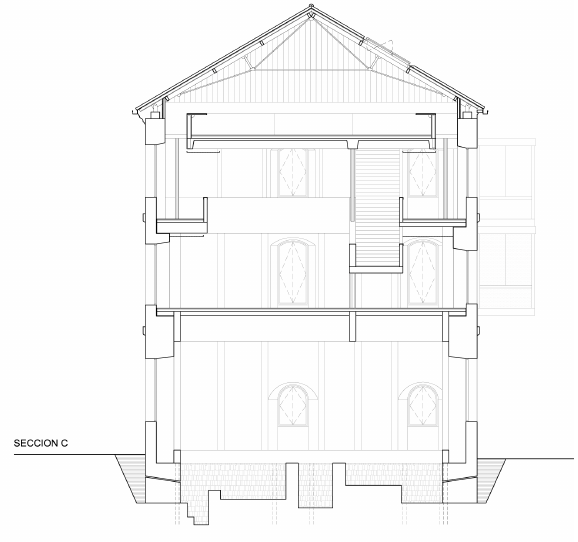
Figure 12. Cross-section of the project. Under the floor are the archaeological remains recovered.